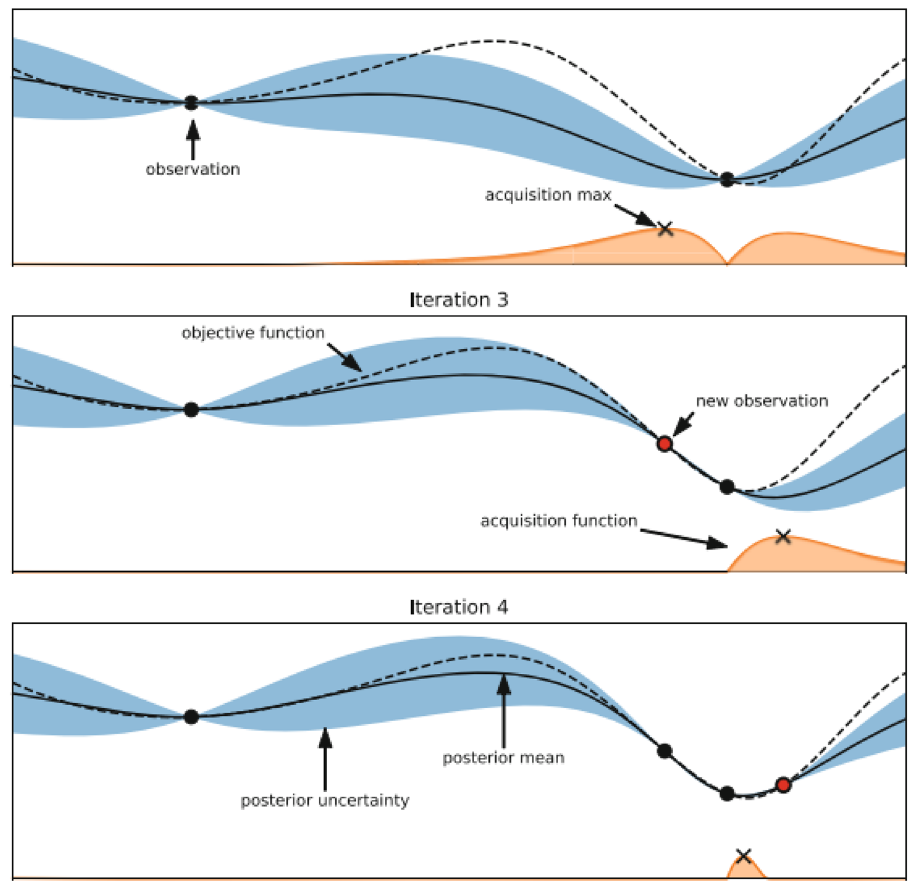
Figure 1. Illustration of Bayesian optimization on a 1 D function. The graph depicts a Gaussian process approximation of the objective function and an acquisition function in the lower portion. The mean of the objective function is represented by the solid line and the dashed line represents the actual objective function. The blue region shows the predictive uncertainty. The acquisition function is represented by the orange curve. The acquisition function is maximum where the Gaussian process gives a low objective value with high uncertainty. Note. Adapted from Feurer and Hutter 1